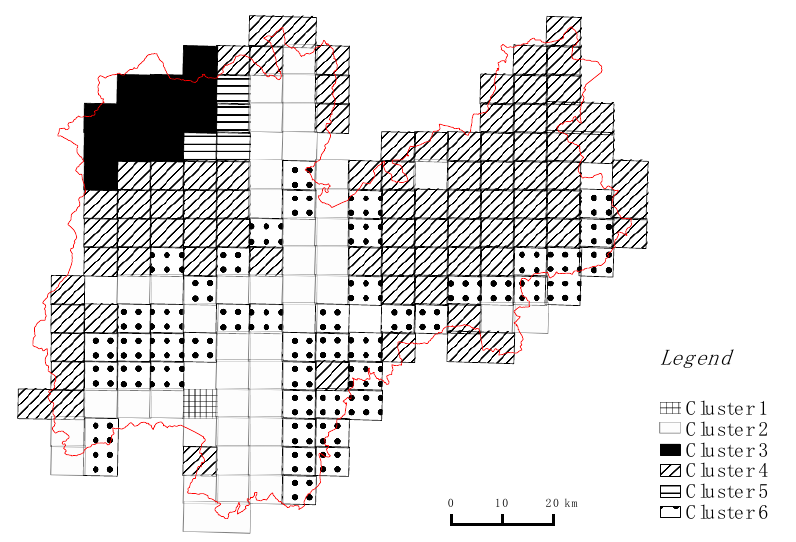
Figure 5. Cluster analysis results overlaid on the Trentino Province area boundary (in red). Table 2. Summary results of the species indicator analysis, with the species most represented and a short description for each zone.